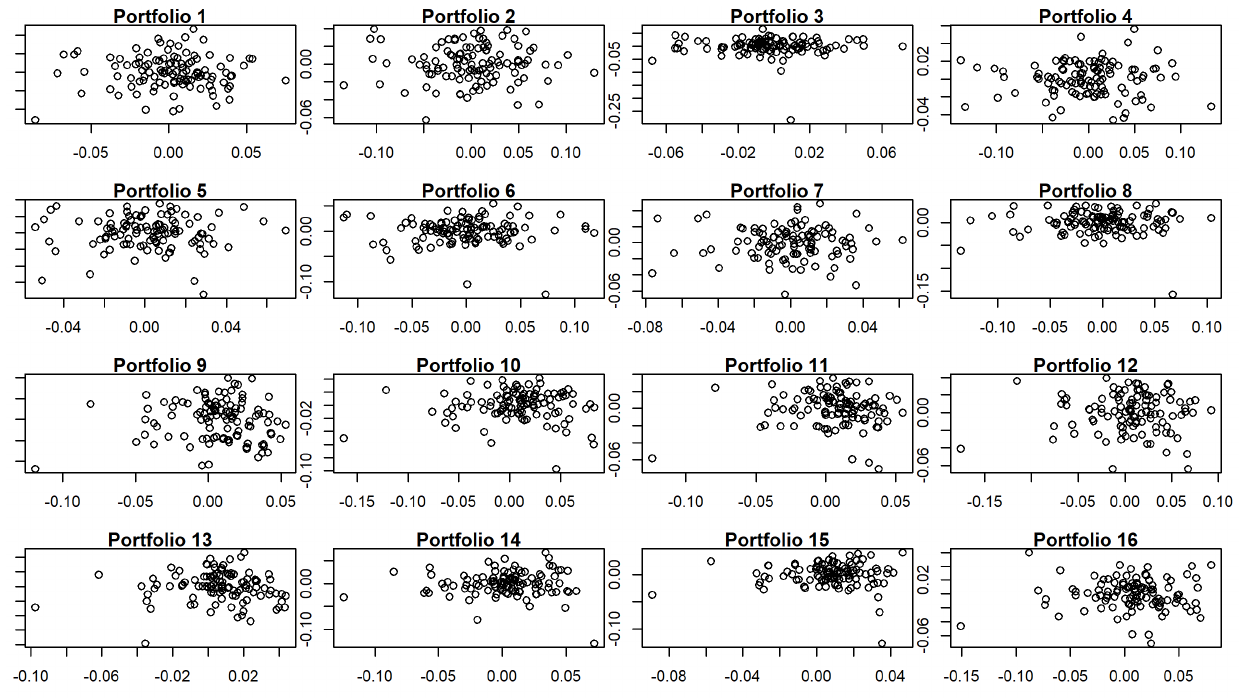
Figure 7. Residuals vs. fitted values in TS regression for 5-factor model for the whole